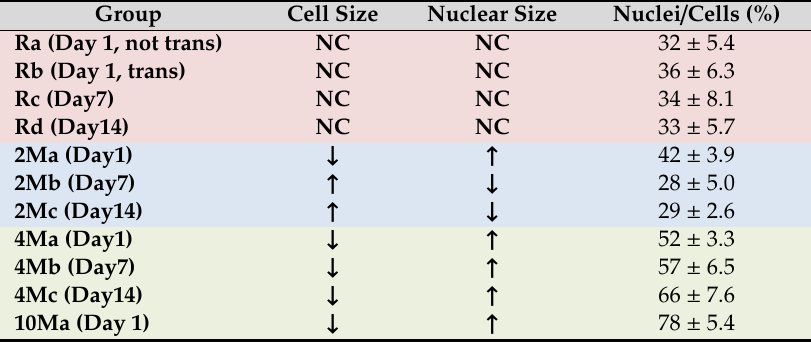
Table 3. Ratio of average areas—Nuclei / Cells. Averages of the cell and nuclei sizes of each subgroup were used for N / C ratio calculation.